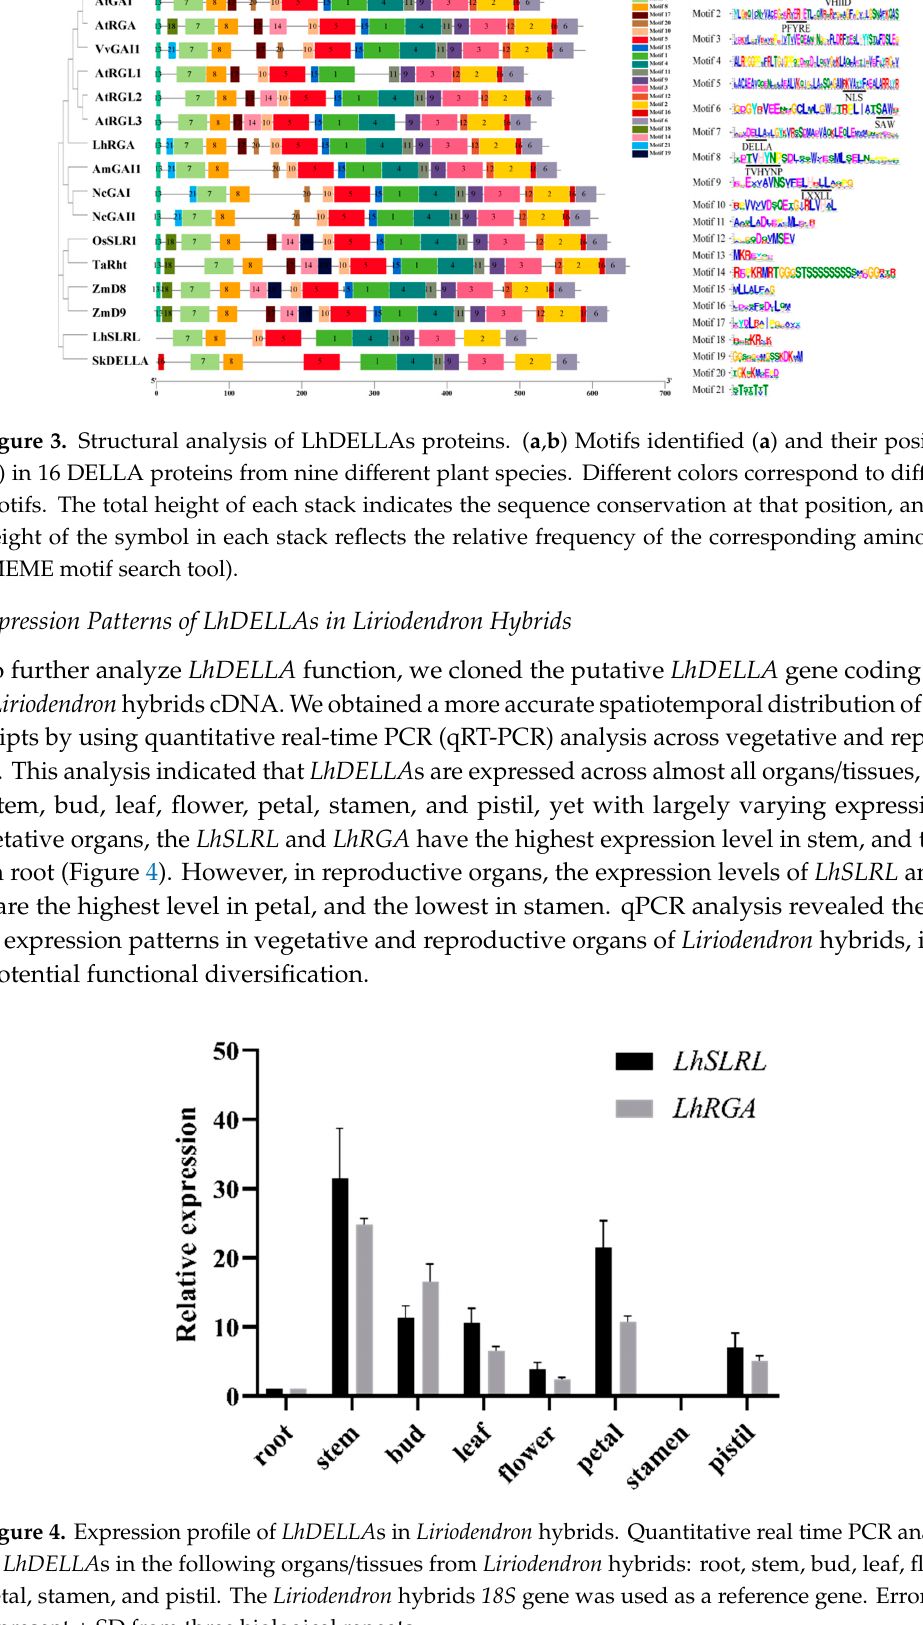
Figure 2. Sequence alignments of LhDELLAs to AtDELLAs. Amino acid sequences were aligned using DNAMAN 8. The conserved domains of the DELLA protein are framed by green lines. Identical and similar amino acid residues were shaded with black, pink, and blue, respectively.